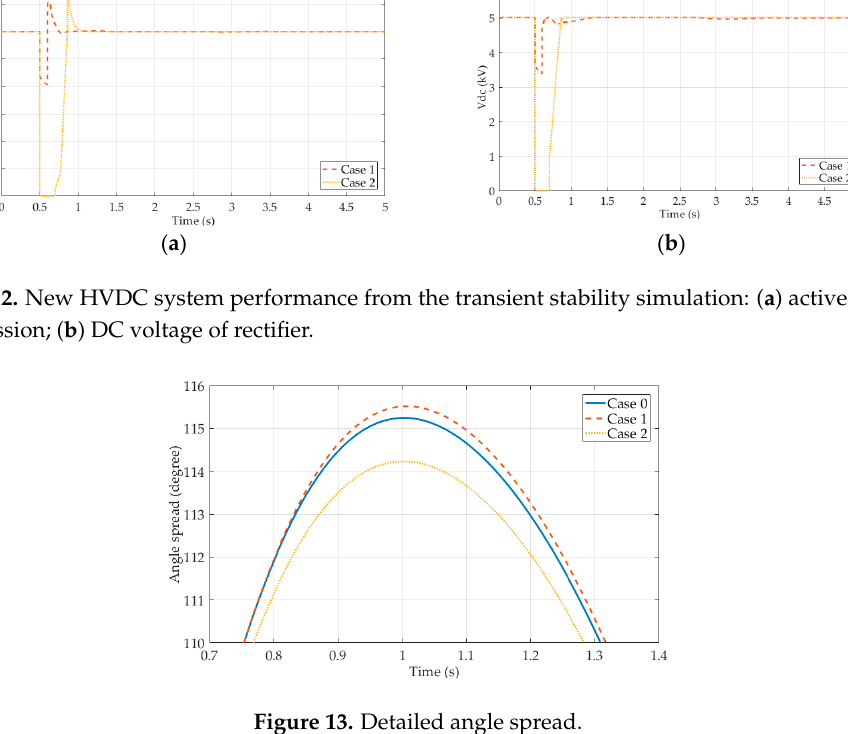
Figure 12. New HVDC system performance from the transient stability simulation: ( a ) active power transmission; ( b ) DC voltage of rectifier.